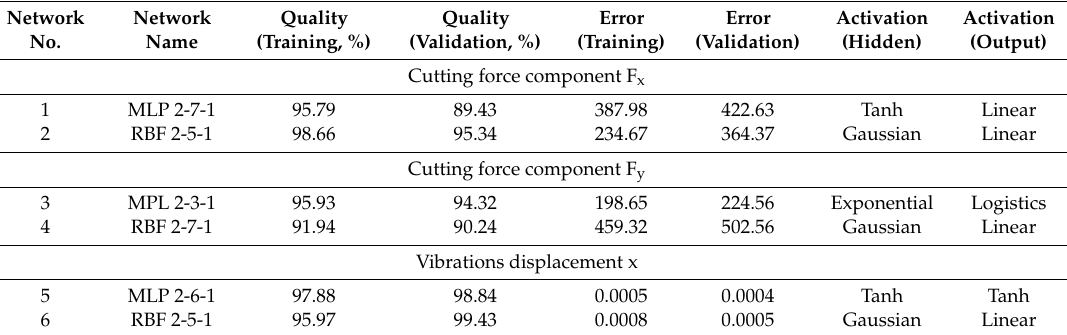
Table 5. Characteristics of MLP and RBF networks for the cutting force components F x , F y and vibrations displacement x for AZ91D alloy.